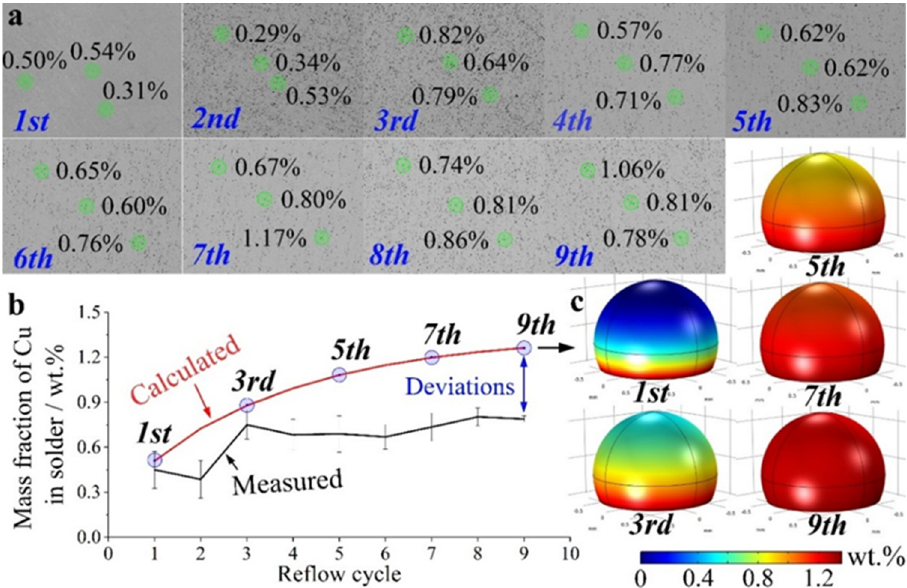
Figure 3. EPMA results for the Cu mass fraction in solder ( a ), plots of the measured and calculated Cu mass fractions ( b ) and simulations for the Cu distribution in solder balls ( c ) during the nine-time reflow process.